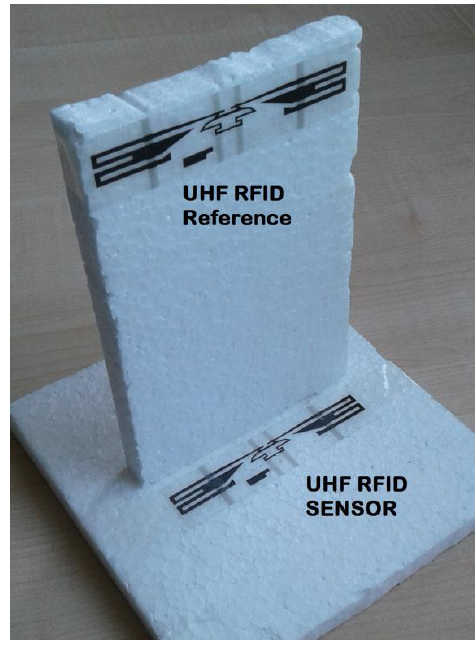
Figure 4. Prototype of Soil Moisture Sensor using two adhesive UHF RFID tags. The Sensor tag is place 12 mm over the soil. A Reference tag is 100 mm apart from the soil.